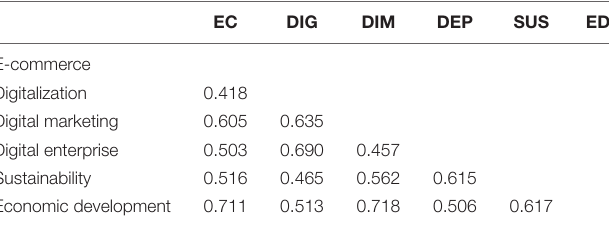
TABLE 3 | Heterotrait–monotrait